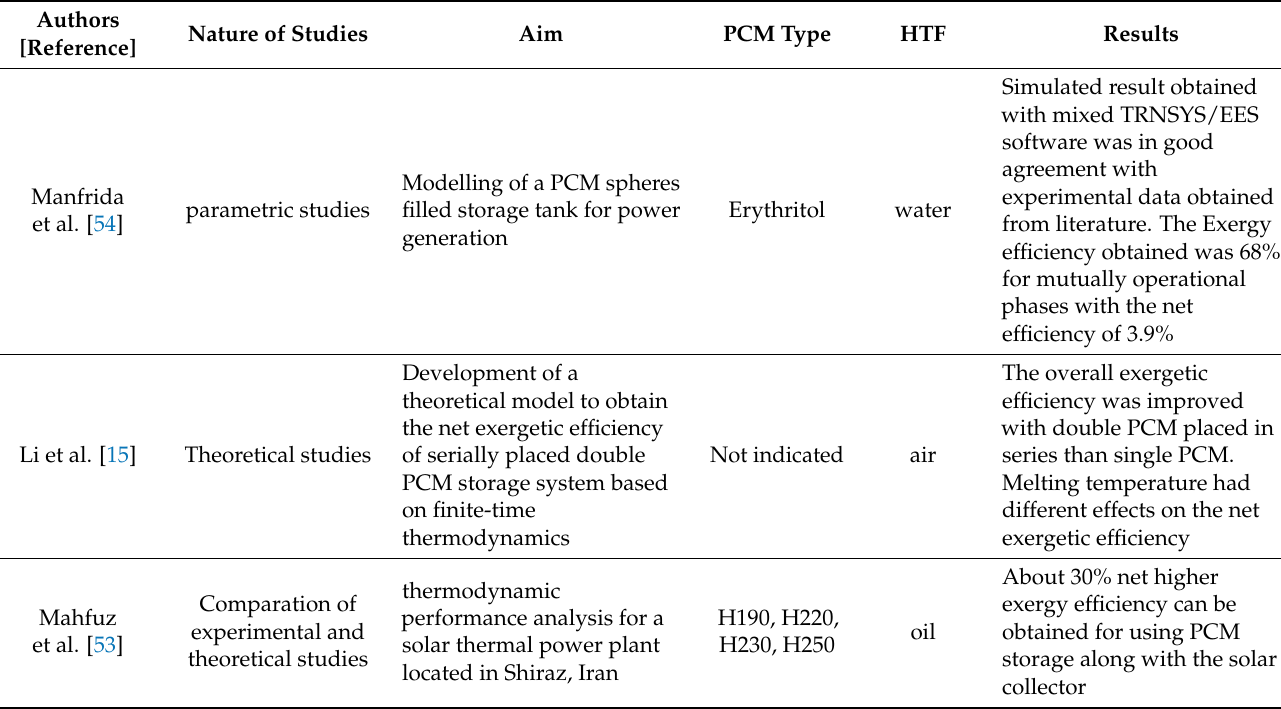
Table 3. Results of some of the studies presented on solar power generation and the PCM